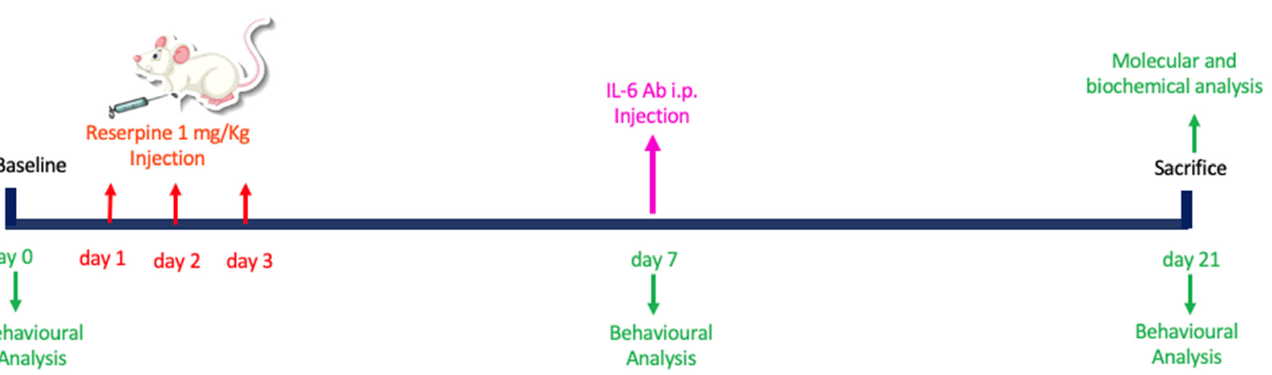
Figure 1. Timeline of the experiment .